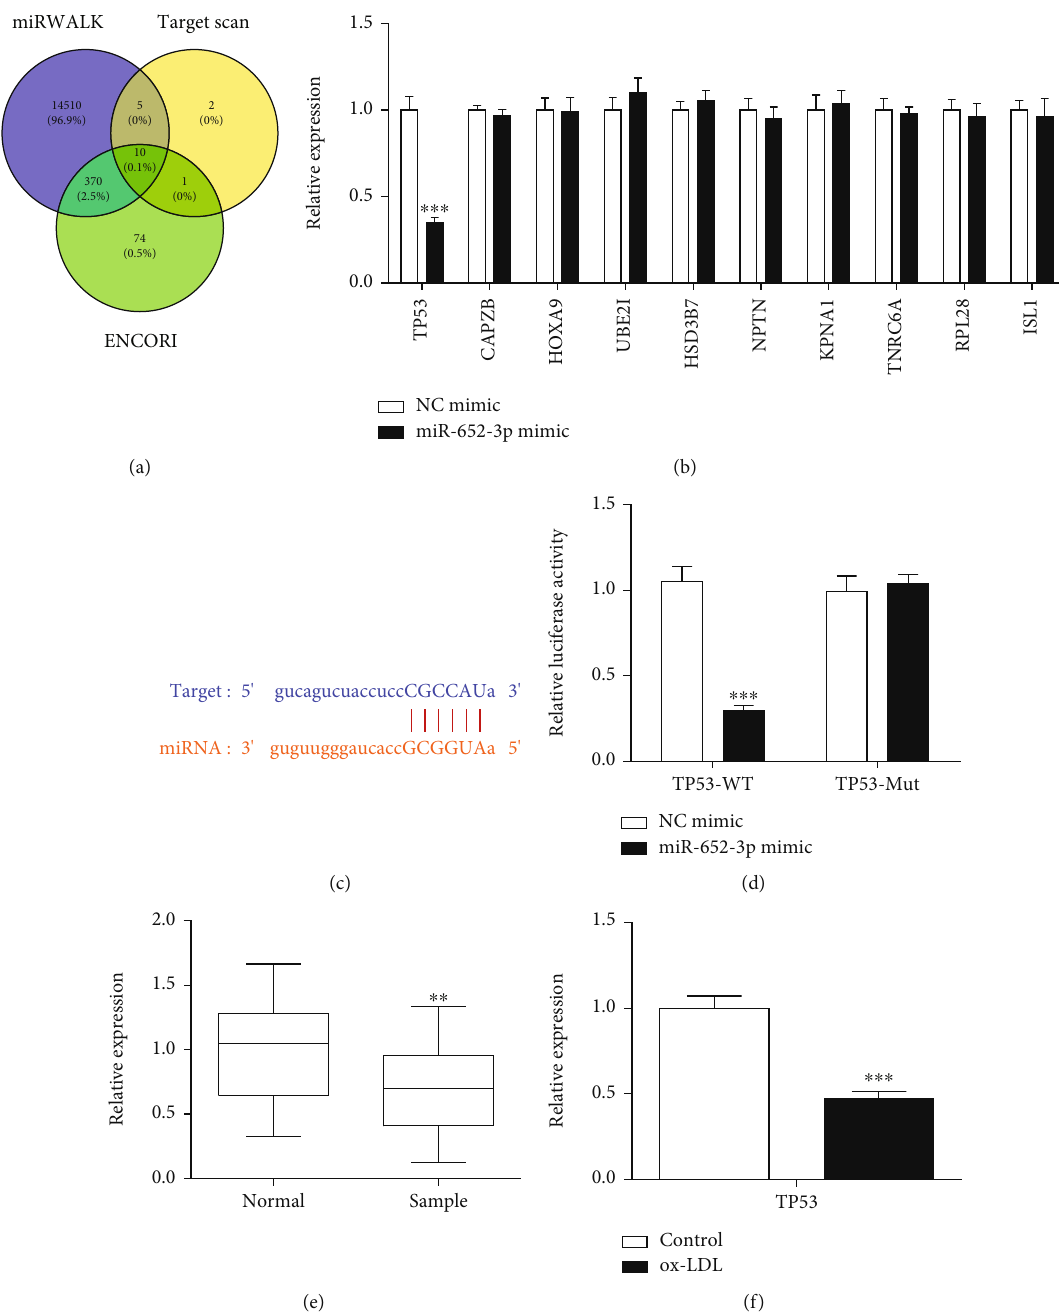
Figure 5: MiR-652-3p targets TP53 in AS. (a) Based on the database of miRWalk, TargetScan, and ENCORI online databases, a total of 10 crossover target genes were obtained. (b) Q-PCR was undertaken to detect the levels of TP53, CAPZB, HOXA9, UBE2I, HSD3B7, NPTN, KPNA1, TNRC6A, RPL28, and ISL1. (c) The binding site between miR-652-3p and TP53. (d) miR-652-3p mimic could reduce TP53 level in the wild group but did not a ff ect the mutant group. (e) TP53 was expressed lower in AS serum samples. (f) After ox-LDL treatment, TP53 expressed lower in macrophages. ∗∗ P < 0 : 01 , ∗∗∗ P < 0 : 001